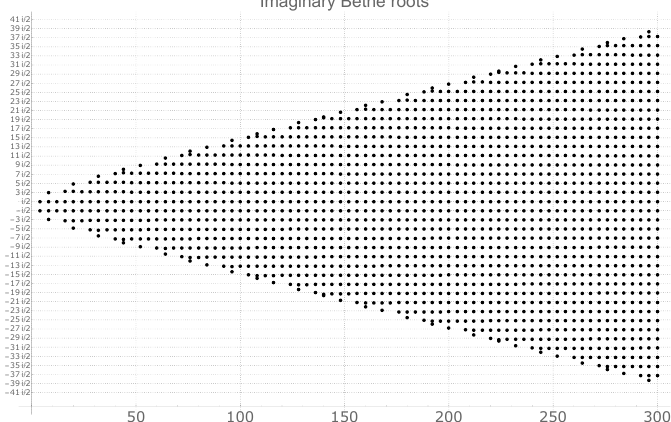
Figure 4: Imaginary Bethe roots for system sizes N = 4 to N =